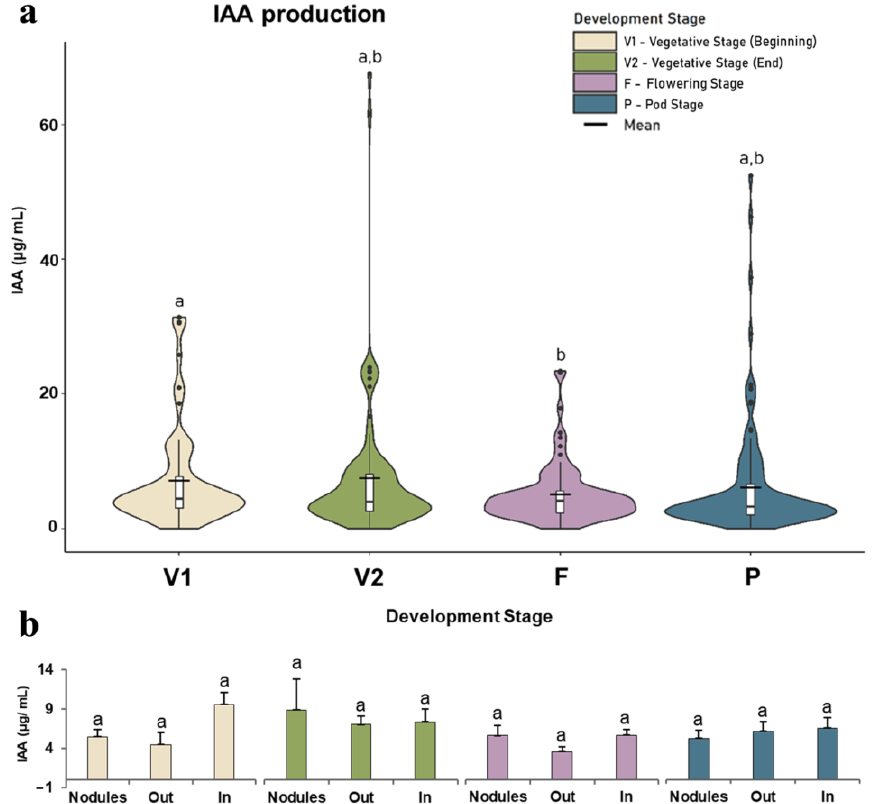
Figure 3. Bacterial ability to produce indole-3-acetic acid (IAA). ( a ) Violin plot representation of the overall IAA production ability of bacteria isolated at each plant growth stage (beginning of the vegetative stage, V1; end of the vegetative stage, V2; flowering stage, F; and pod stage, P). The outlier values (black dots) and averages (black lines) are marked. ( b ) Bar chart representation of the average IAA production in each root compartment (rhizoplane outside the root—out, inside the root—in, and in nodules—nodules). Between 65 strains at stage V1 and 115 strains from stage P were used to construct violin plots. Chart bar values are the means ± standard deviation of IAA production from 15 strains belonging to the V1 stage from outside (out-of-root compartment) to 50 strains from the P stage in Out (root compartment). Significant differences ( p < 0.05) among developmental stages (violin plots) and root compartments (bar charts) are represented by different lowercase letters (a and